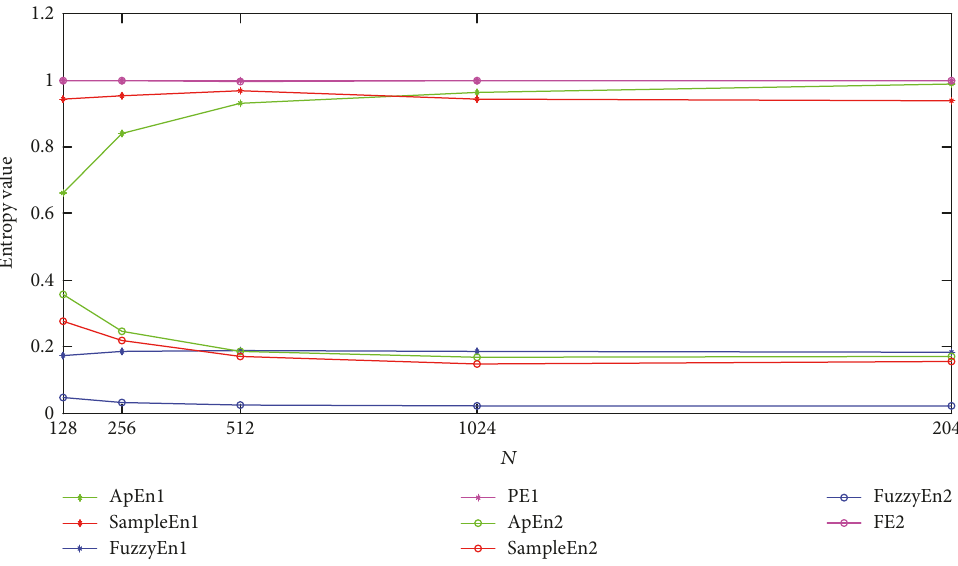
Figure 2: Four kinds of entropy values with di ff erent data